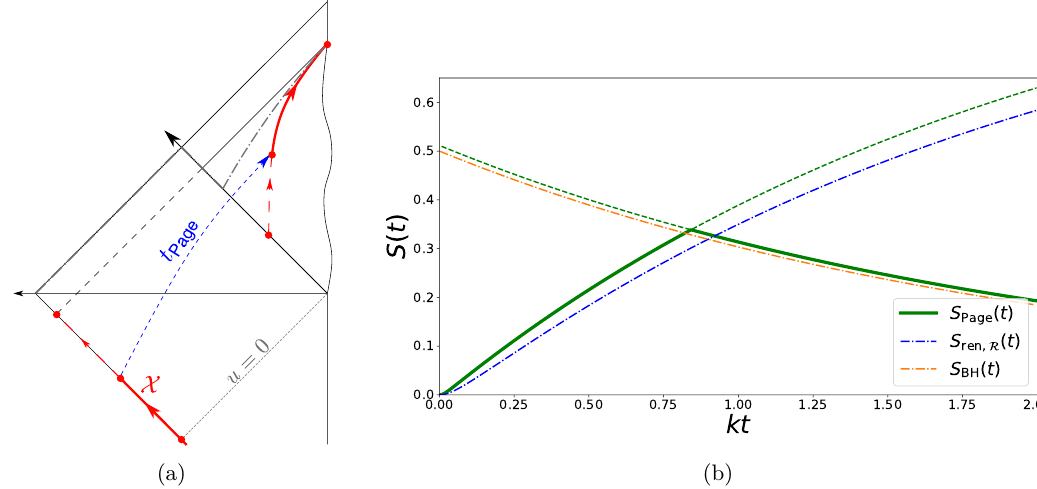
Figure 8 . (a) The island trajectories (in red). At the Page time, the dominance of the two islands changes. The initial island is on the past horizon. The final island is outside of the event horizon and the apparent horizon (gray dot-dashed line) for its entire lifetime. (b) The Page curve for is given by the solid line in green. There is a small shift to a smaller Page k = 0 . 01 , T = 1 2 π